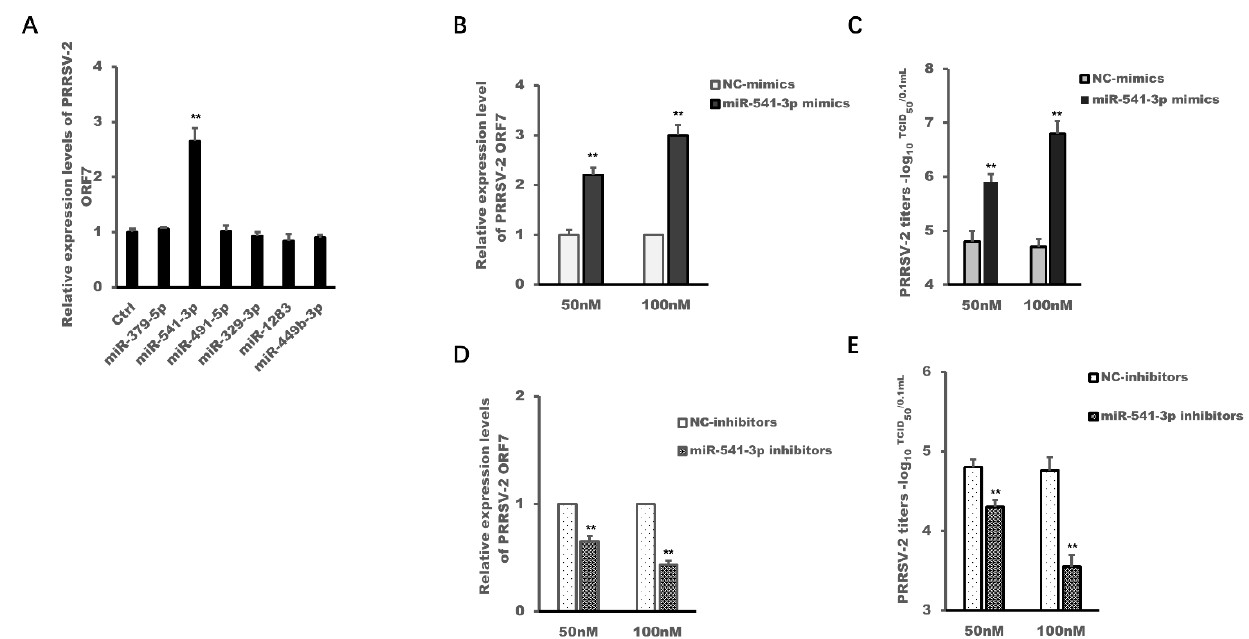
Figure 1. miR-541-3p promoted the replication of PRRSV-2 in MARC-145 cells. ( A ) MARC-145 cells were transfected with miR-379-5p mimics, miR-541-3p mimics, miR-491-5p mimics, miR-329-3p mimics, miR-1283 mimics or miR-449b-3p mimics, and 24 h later, the cells were infected with PRRSV-2 at a multiplicity of infection (MOI) of 0.1. Twenty-four hours later, the cells were collected for the analysis of RNA levels of Open reading frame 7 (ORF7) of PRRSV-2 by quantitative real time polymerase chain reaction (qRT-PCR). MARC-145 cells were transfected with miR-382-5p mimics ( B , C ), miR-382-5p inhibitors ( D , E ), negative control mimics (NC-mimics) or negative control inhibitors (NC-inhibitors) at a final concentration of 50 nM or 100 nM, and 24 h later, the cells were infected with PRRSV at an MOI of 0.1. Twenty-four hours later, the cells were harvested for the analysis of RNA levels of PRRSV-2 by qRT-PCR ( B , D ) and for the analysis of the PRRSV-2 titers by 50% tissue culture infected dose (TCID 50 ) ( C , E ). Data are presented as the mean + standard deviations (SD). Student’s t test was used for statistical analysis. All experiments were repeated at least three times with similar results. ** p < 0.01.